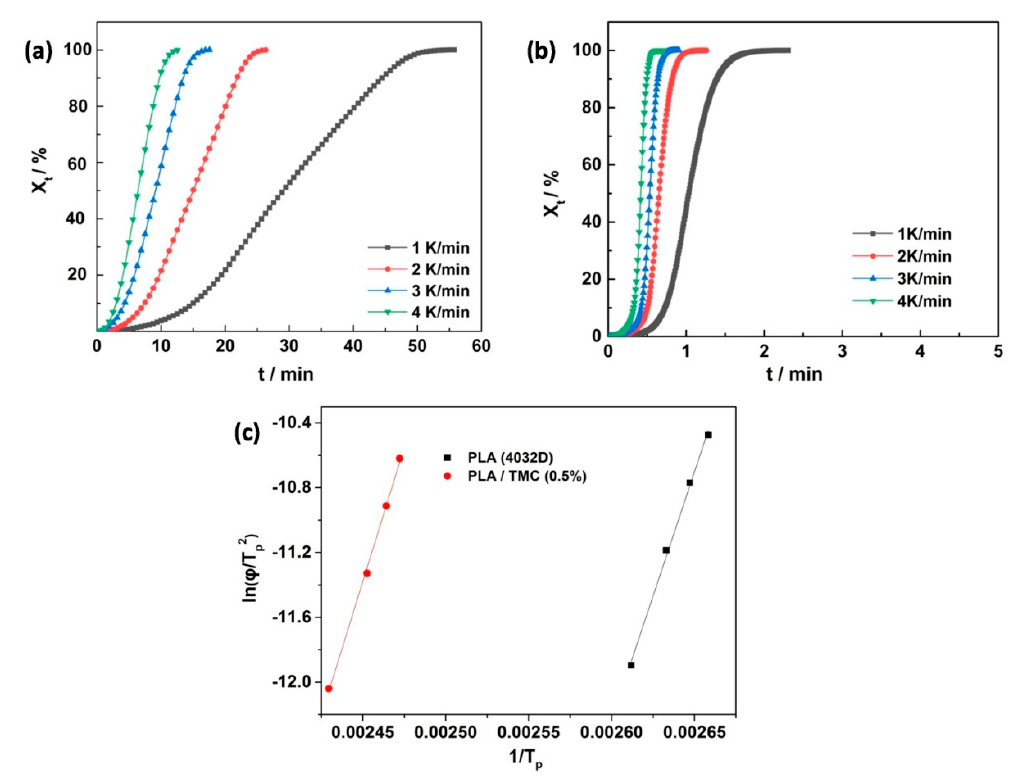
Figure 4. Crystallinity of ( a ) neat PLA and ( b ) PLA / TMC (0.5 wt%) versus crystallization time at varying crystallization rates; ( c ) Kissinger plots of ln ( ϕ / T p2 ) for estimating crystallization activation energy.